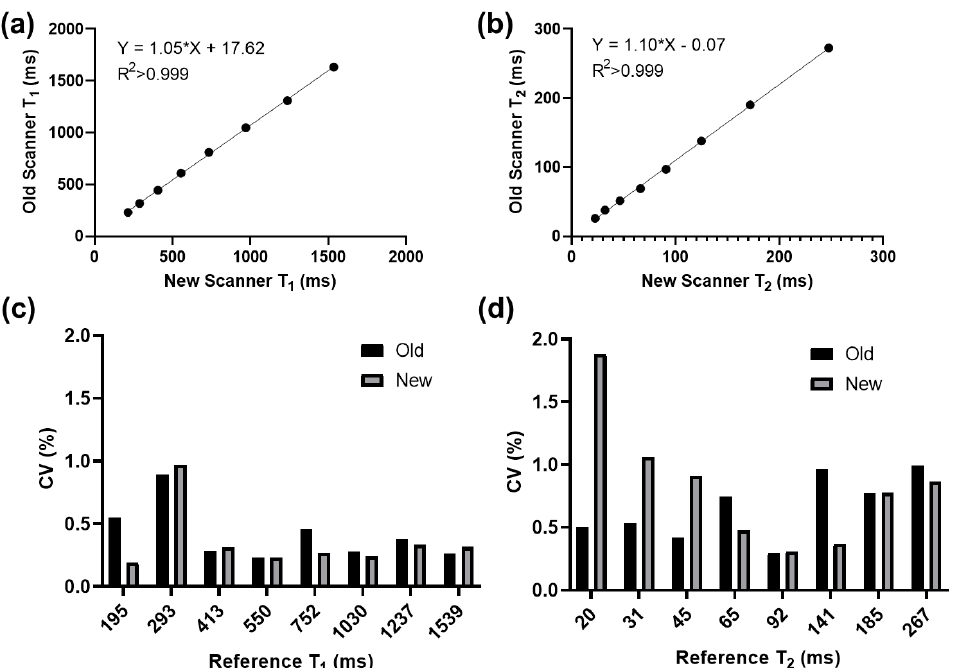
Figure 3. Correlation and repeatability analyses on the old scanner with the ‘weak gradient’ spiral and the new scanner with the ‘strong gradient’ spiral. ( a , b ) Correlation plots showing very strong inter−scanner correlation ( p < 0.0001). Data points are averages from the five repeated acquisitions. ( c , d ) Bar plots of CV showing that the repeatability of T 1 and T 2 measurements (as computed from the five repeated scans) is comparable between the two scanners (<2% difference).